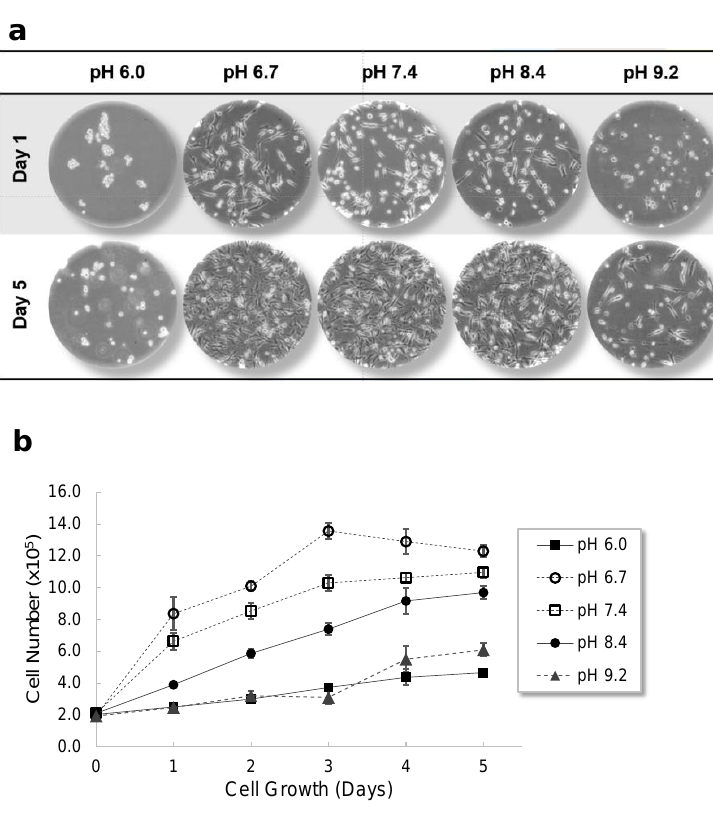
Figure 2. The effect of external pH on the growth of MDA-MB-231 cells, a metastatic human breast cancer cell line. MDA-MB-231 cells were seeded in a 12-well plate and they were incubated at five different pHs of DMEM: pH 6.0, pH 6.7, pH 7.4, pH 8.4, and pH 9.2. ( a ) Cells were imaged by a light microscope on day 1 and day 5. ( b ) The number of cells was also counted everyday by a hemocytometer.